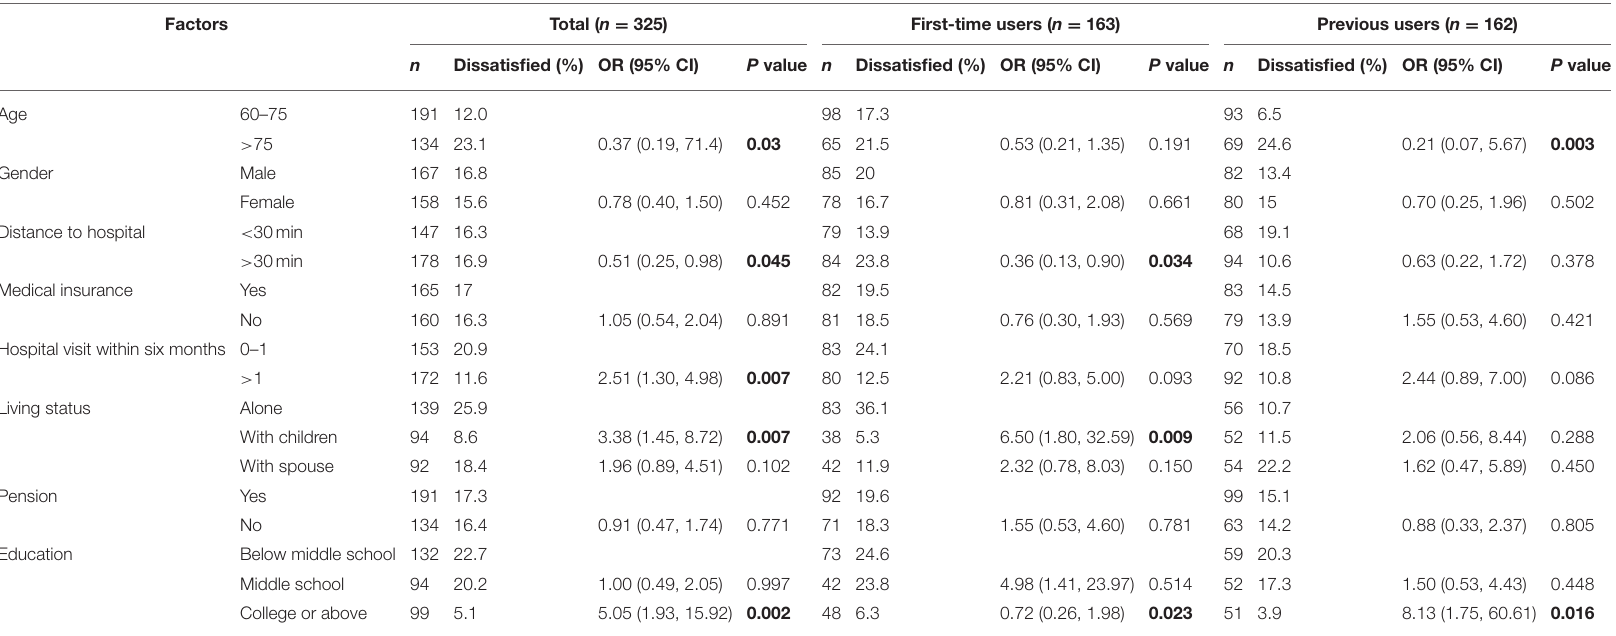
TABLE 3 | Univariate analyses of the factors influencing the satisfaction of older adults. Factors Total ( n = 325) First-time users ( n = 163) Previous users ( n = 162) Dissatisfied (%) OR (95%